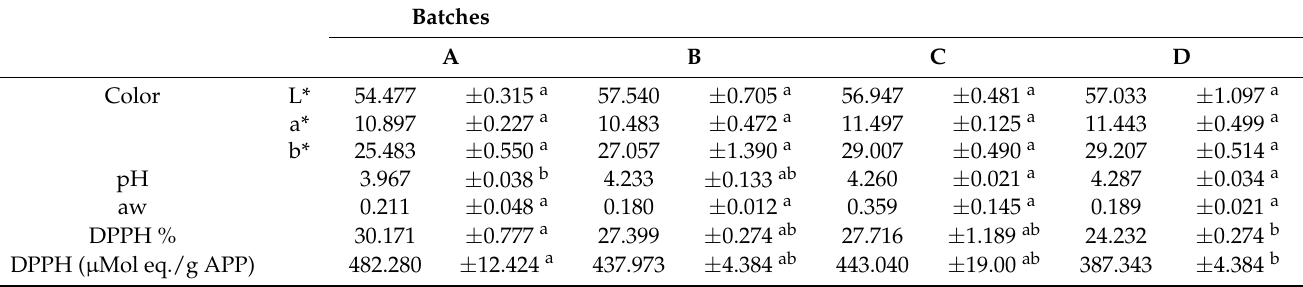
Table 2. Mean and standard error values of physicochemical parameters of batches of apple pomace powder (APP) collected from October to December, on four different days (A, B, C,